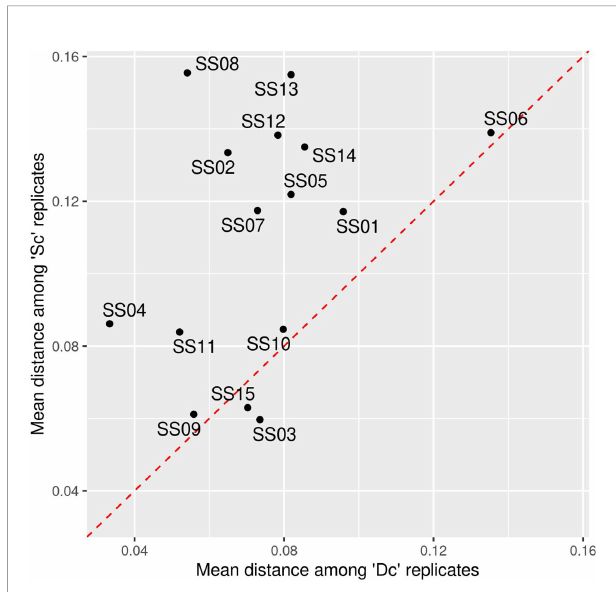
FIGURE 3 | Mean dispersion using Bray-Curtis distances among technological replicates prior (Sc) and after (Dc) homogenization across 15 fecal samples (SS01 to SS15). The red dotted line indicates equality of dispersion among ‘ Sc ’ and ‘ Dc ’